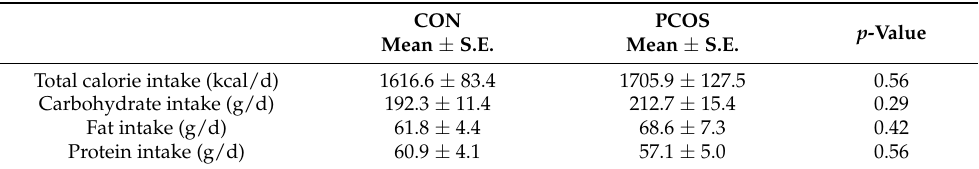
Table 1. Self- reported macronutrient and total calorie consumption in PCOS and CON groups at baseline.